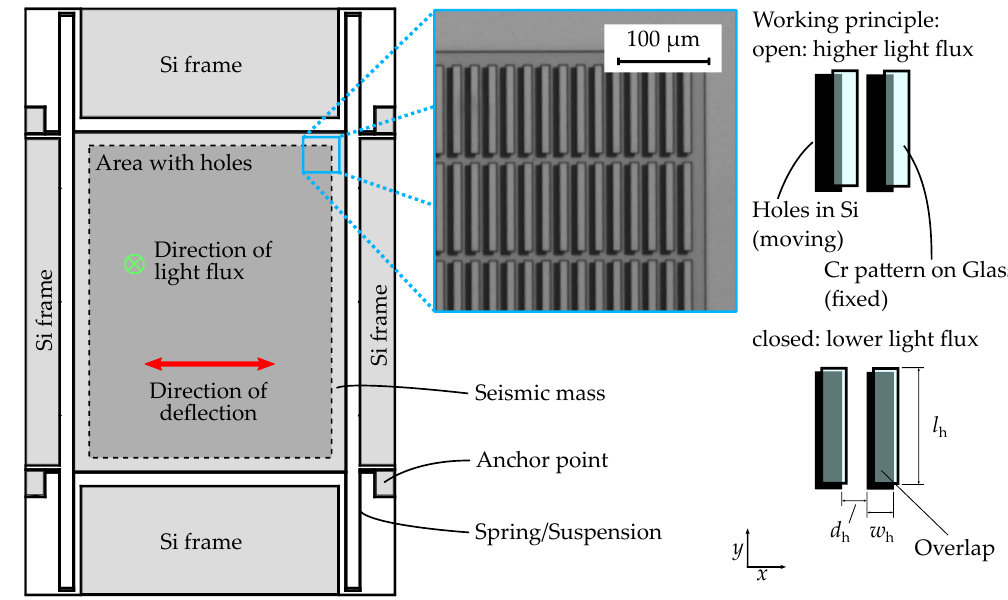
Figure 1. Schematic of the optomechanical MEMS transducer. Two identical grids of rectangular holes (one etched into a Si moving mass, one deposited onto glass) are placed on top of each other such that any movement of the seismic mass causes a modulation of the light flux passing through the